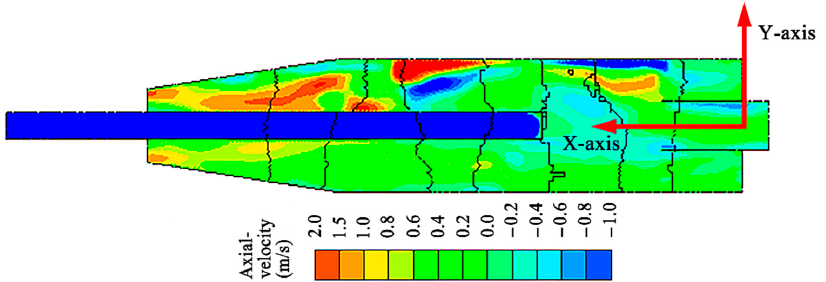
Figure 10. Axial velocity distribution at central section (rotational speed is 900 r/min).